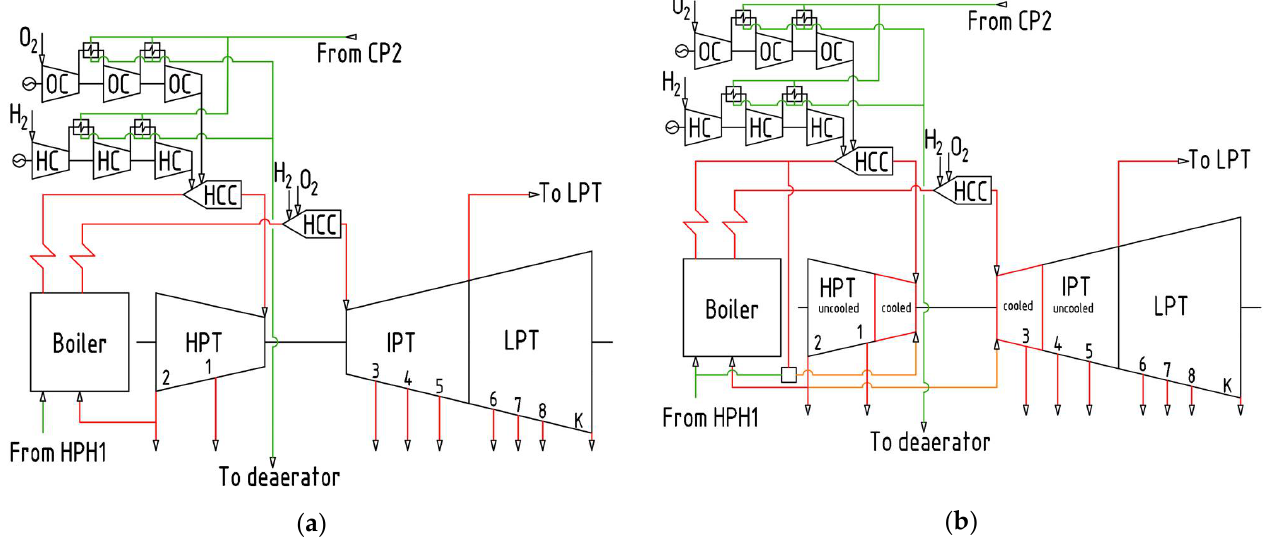
Figure 2. The heat flow diagram of the power unit heat: ( a ) Diagram with HCC; ( b ) diagram with HCC, HPT cooled by main steam mixed with feed water, and IPT cooled with steam from HPT exhaust.